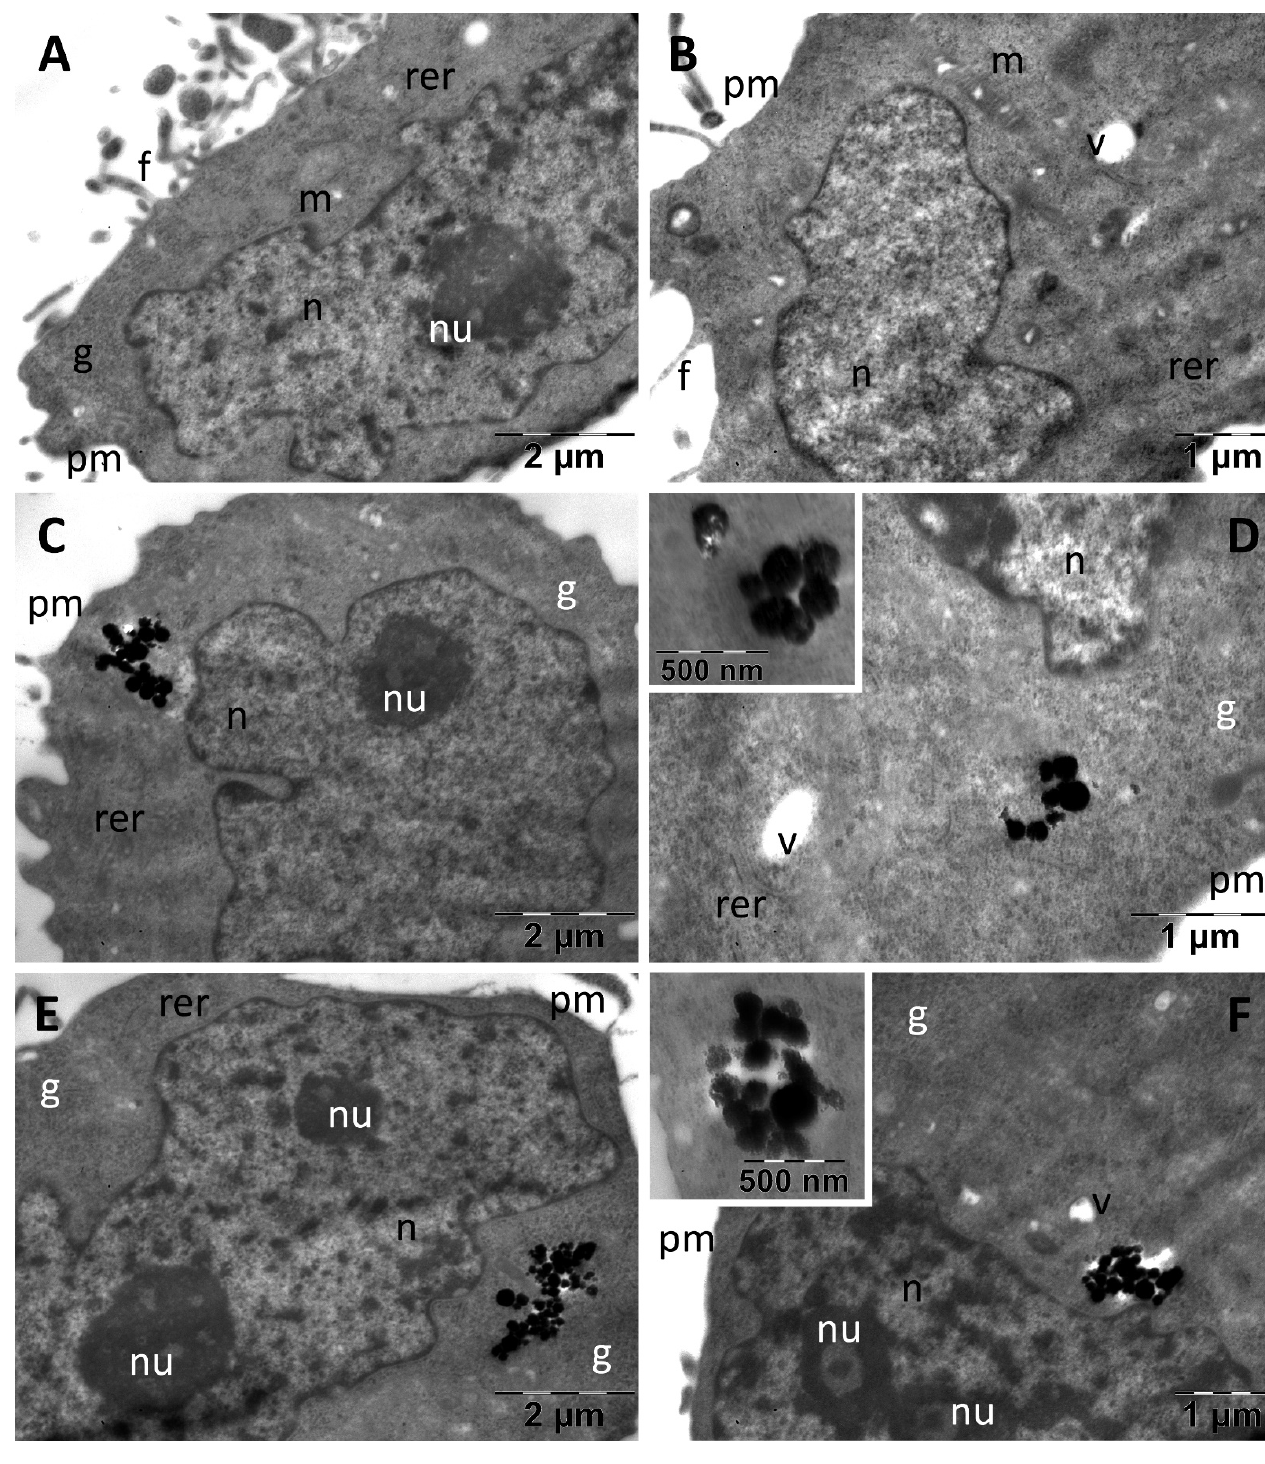
Figure 8. TEM images of A375 melanoma cells showing their normal ultrastructure in control group ( A , B ) and internalization of the DHBH@MNC test group ( C , D ) and the PDHBH@MNC test group ( E , F ). f: filopodia; g: glycogen; m: mitochondria; n: nucleus; nu: nucleolus; pm: plasma membrane; rer: rough endoplasmic reticulum; v: vacuoles. They contained very large, indented and euchromatic nuclei, with large nucleoli. In the cytoplasm, only a few mitochondria were identified as well as several profiles of rough